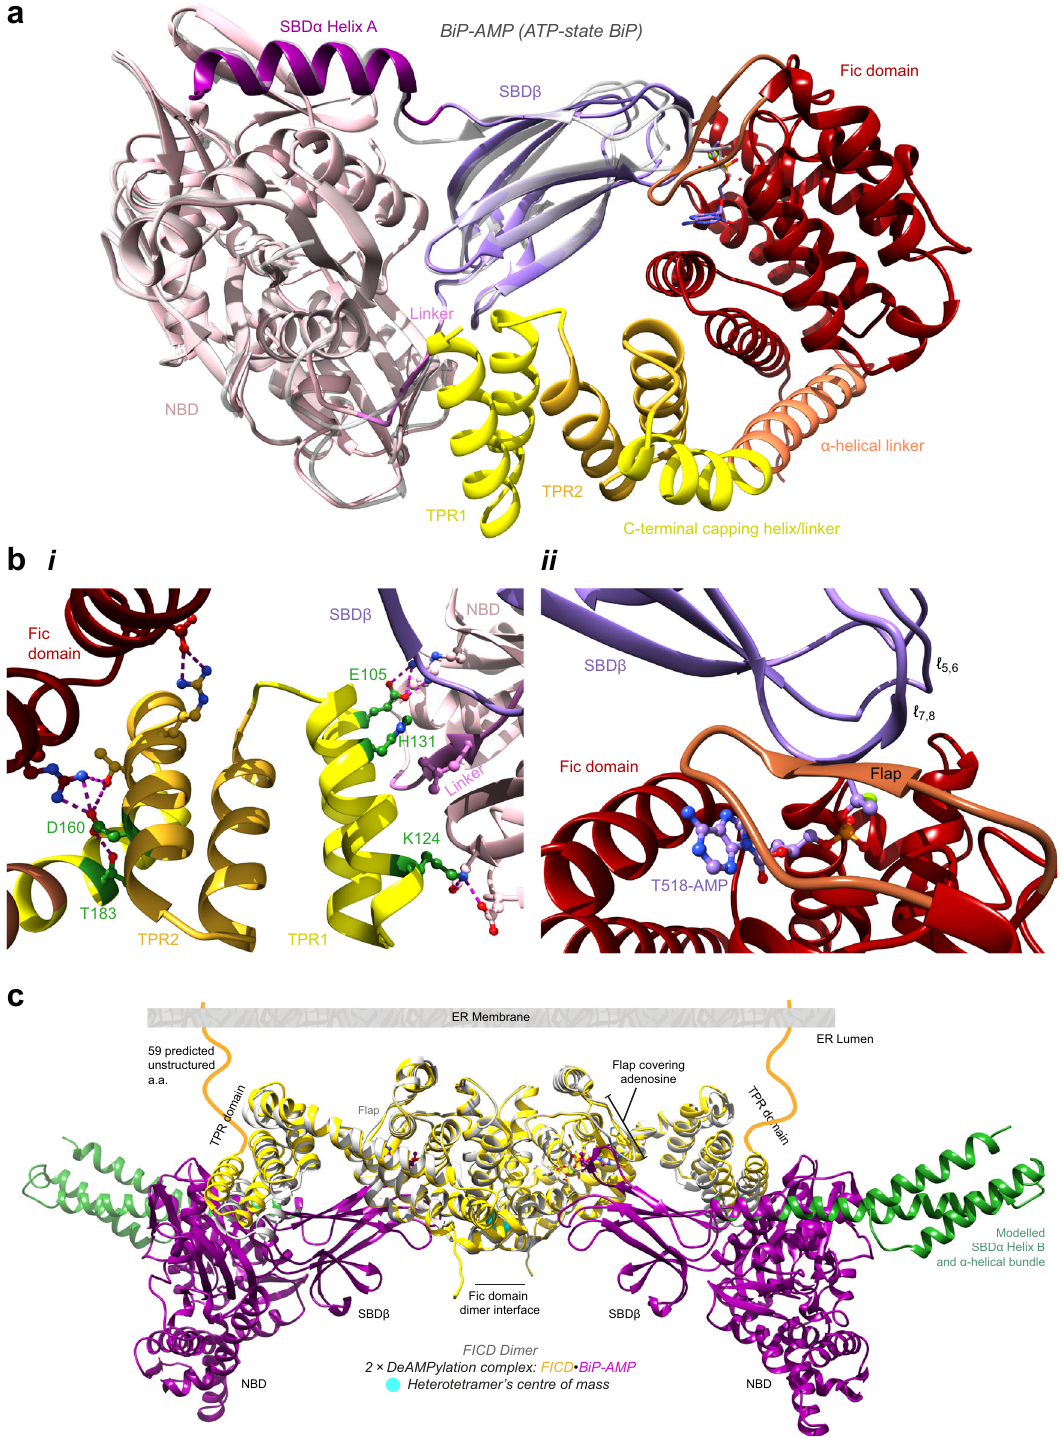
Fig. 1 The deAMPylation complex crystal structure. a The deAMPylation complex crystal structure is colour-coded to illustrate its (sub)domain organisation. The ATP-state structure of isolated BiP-AMP (PDB 5O4P, light grey) 4 is superimposed via alignment of its NBD. See Supplementary Fig. 1b – d. b A focus on the two intermolecular interaction surfaces. Selected interdomain contacting residues are shown. Polar interactions are depicted by pink dashed lines. Residues mutated in this study are shown in green. i The interaction of FICD(TPR1) with the tripartite BiP surface (NBD-linker-SBD β ) is highlighted alongside the intramolecular contacts between the FICD ’ s TPR and Fic domain. ii The intermolecular β -sheet formed between the Fic domain fl ap (brown) and the Thr518 bearing BiP(SBD β ) loop ( ℓ 7,8 ) are highlighted. Note, this sequence-independent mode of substrate engagement is characteristic of Fic proteins 15,18 (see Supplementary Fig 2). c Superposition of two heterodimeric crystal structures (purple BiPs and yellow FICDs) with an FICD dimer structure (PDB 4U0U, grey) 24 . The α -helical BiP lid (SBD α , green, missing from the heterodimeric crystal structure) is modelled by alignment with the full-length BiP:ATP structure (PDB 5E84) 71 . The N-terminal unstructured region of FICD is shown in the context of an ER membrane 24 (see Supplementary Movie